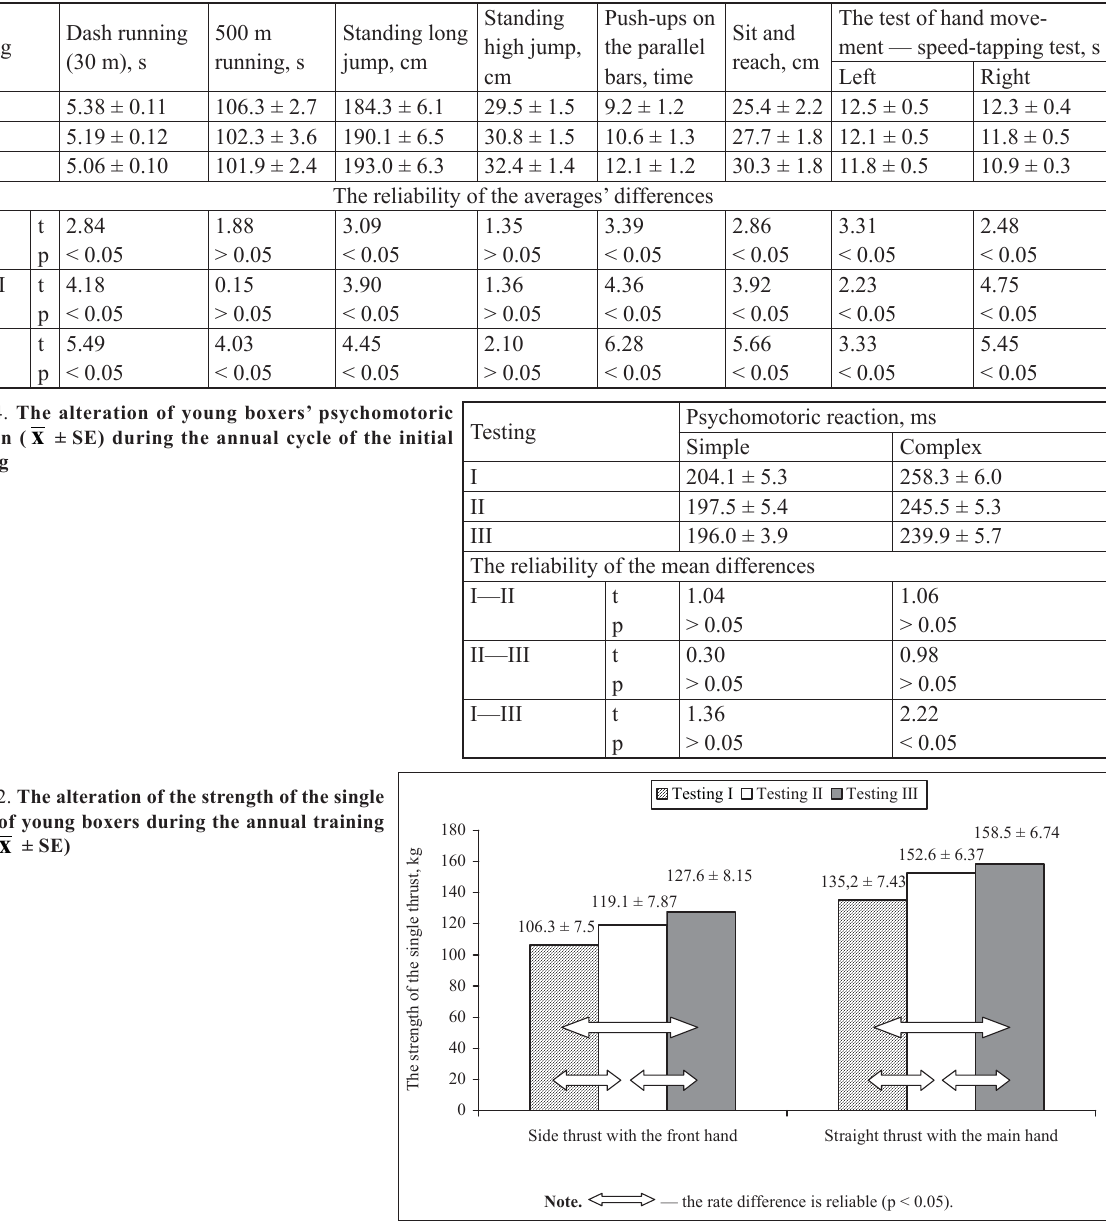
Table 3. The alteration of young boxers’ athletic fi tness during the annual training cycle ( x ± SE)